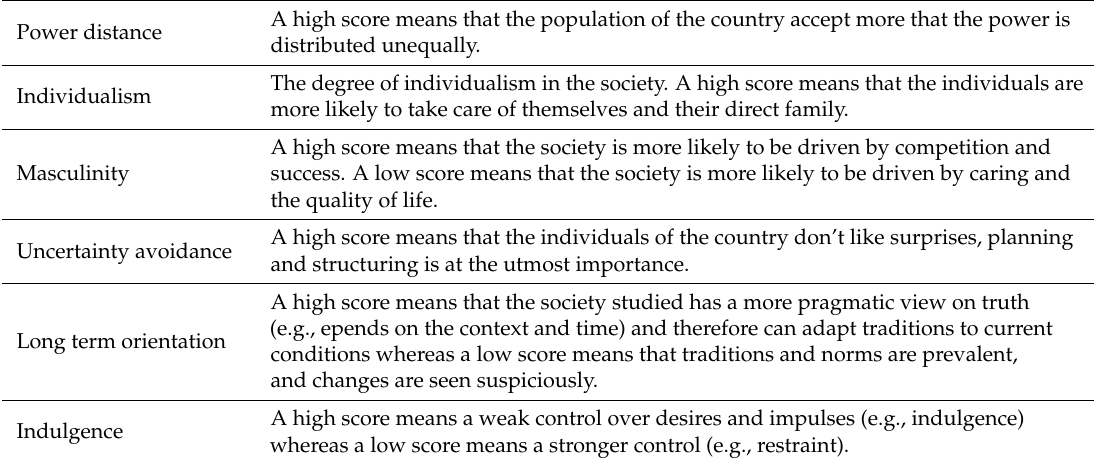
Table 1. Hofstede’s cultural factors. Source: Hofstede